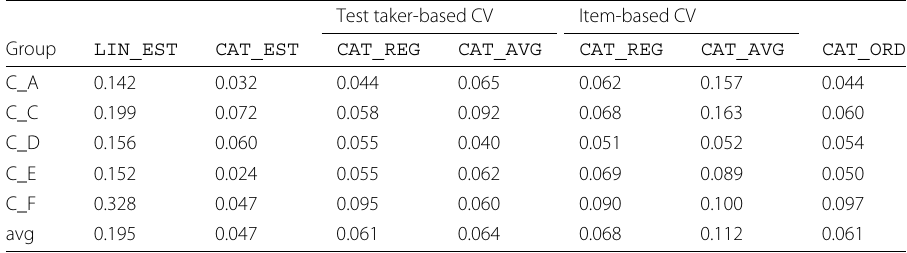
Table 7 Mean squared error (MSE) of the CAT simulations Test taker-based CV Item-based